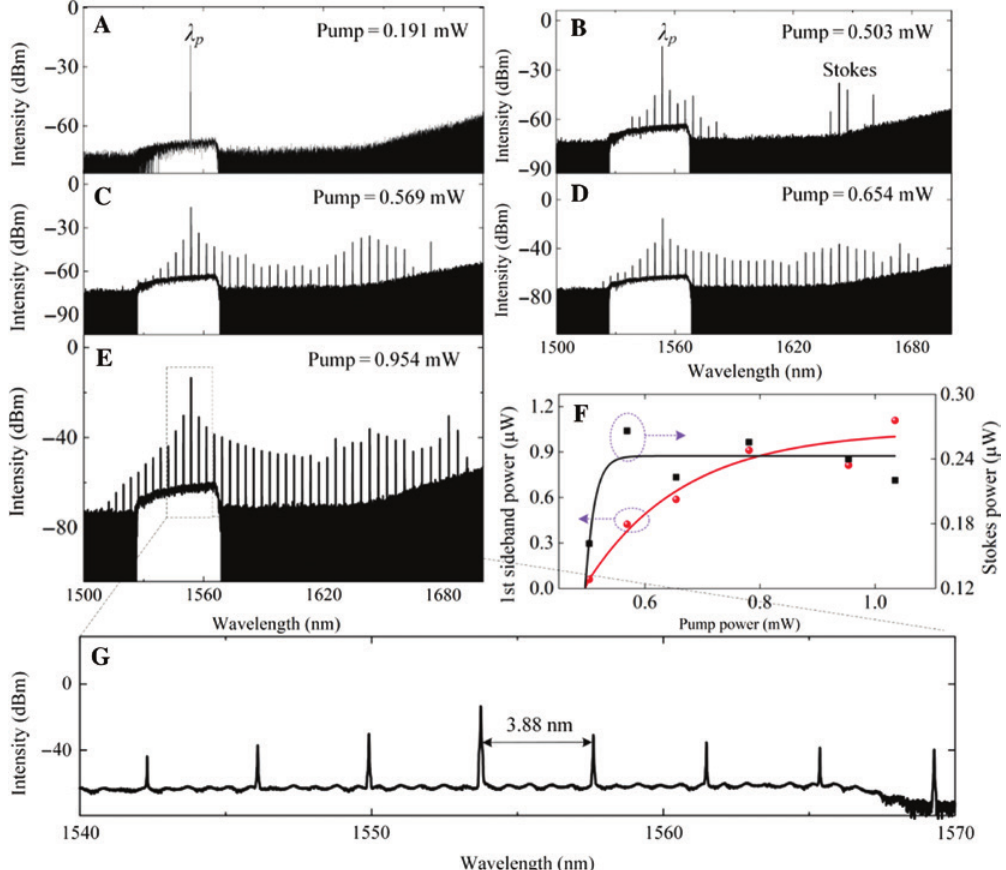
Figure 5: Raman-Kerr frequency comb generation. (A–E) Raman-Kerr frequency comb formation in the functionalized microsphere resonator with a diameter of 139 μ m. (F) First-order sideband power and Stokes power as functions of the pump power. (G) Close-up view of Figure